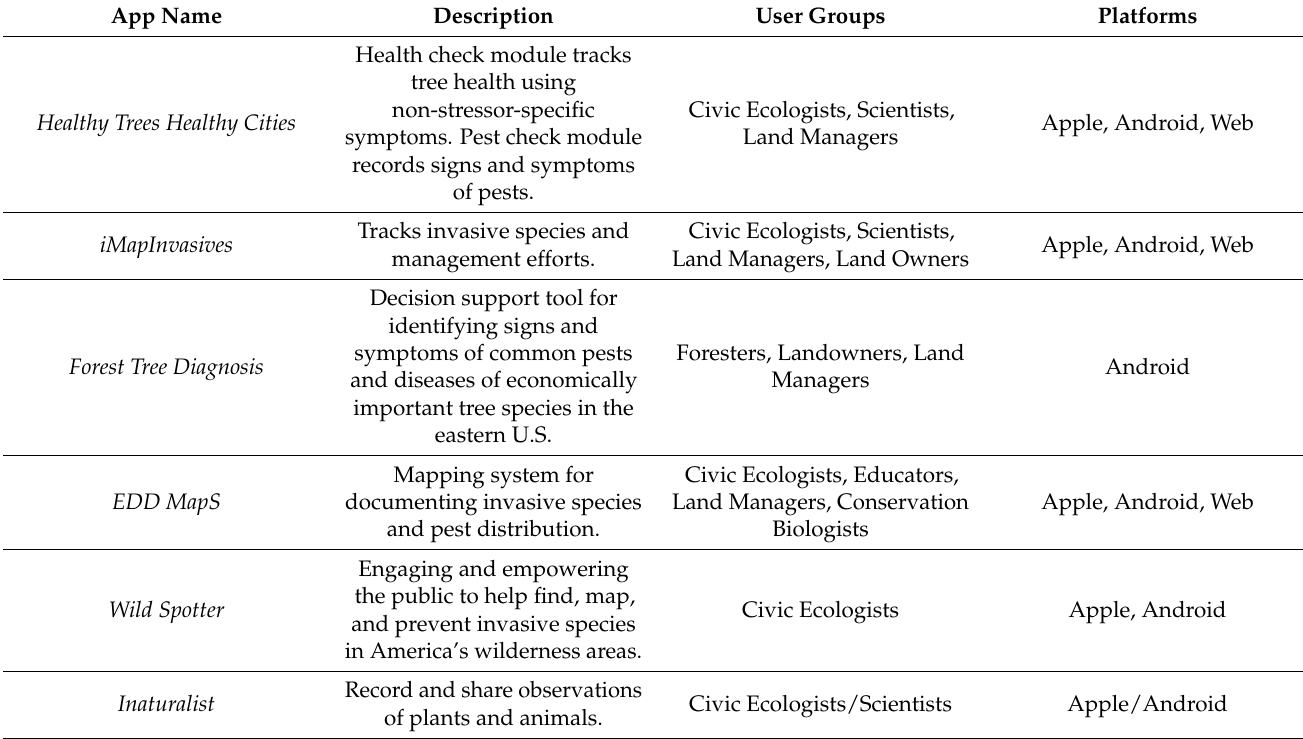
Table 2. Some available apps for monitoring forest health and occurrences of invasive